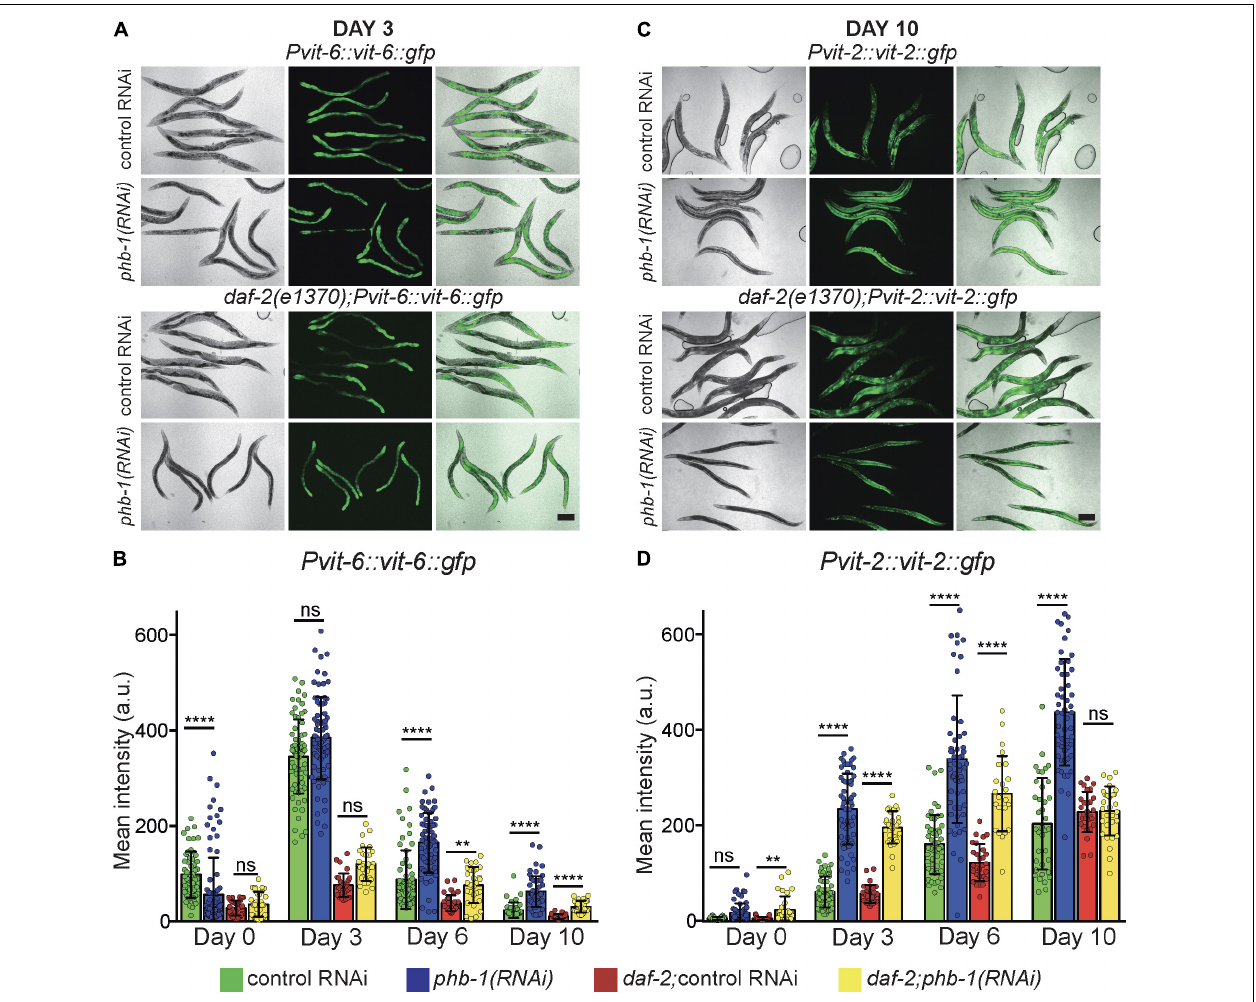
FIGURE 2 | PHB deficiency dysregulates yolk homeostasis in a genetic background dependent-manner. (A) Representative images of VIT-6:GFP at day 3 of adulthood and (B) respective quantification of the mean GFP intensity per worm during ageing; error bars denote SD. (C) Representative images of VIT-2:GFP at day 10 of adulthood and (D) respective quantification of the mean GFP intensity per worm during ageing; error bars denote SD. At least two independent biological replicates of each condition were performed. One-way ANOVA-Dunn’s multiple comparisons test. P -value < 0.01 (**) < 0.0001 (****). Scale Bars: 200 µ